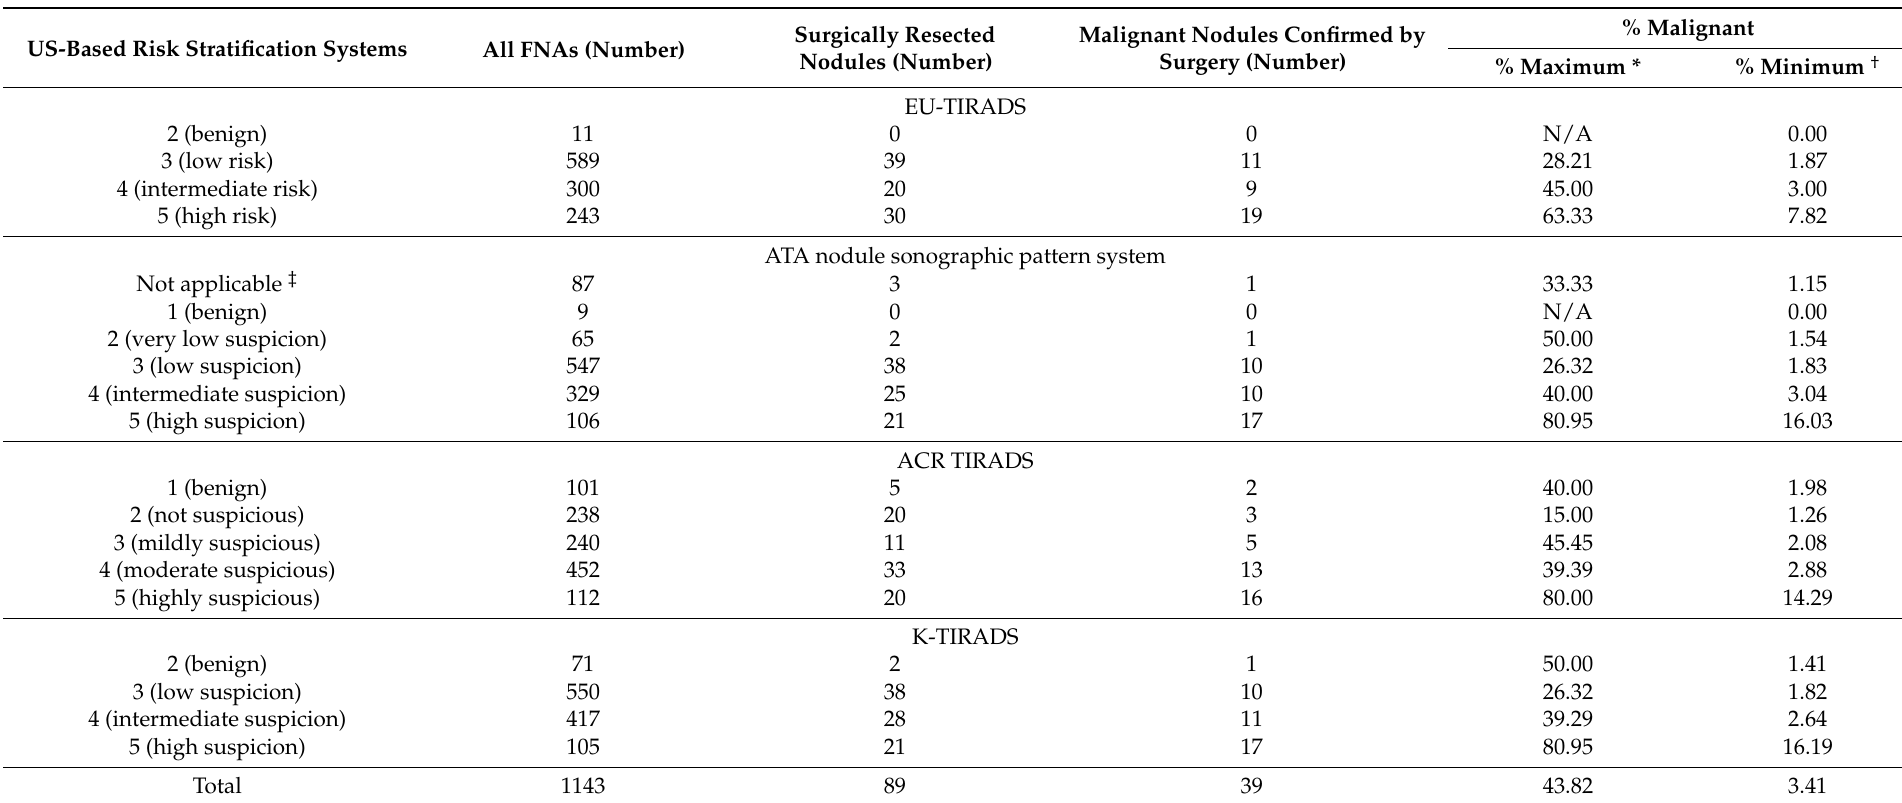
Table 2. Malignancy rates of thyroid nodules with nondiagnostic or unsatisfactory cytopathological results according to categories of ultrasonography-based risk stratification systems. US-Based Risk Stratification Systems All FNAs (Number)